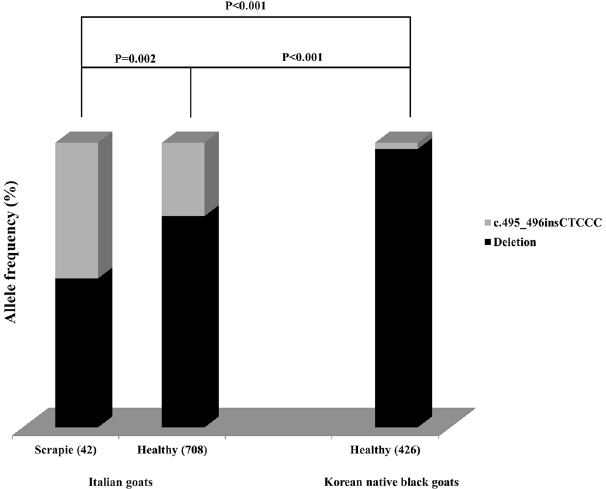
Figure 2. Comparison of the allele distribution of the SPRN c.495_496insCTCCC indel polymorphism between scrapie-affected Italian goats and Korean native black goats. The information of the Italian goats was taken from a previous study 20 . The Italian goats were Maltese, Red Mediterranean, Capra dei Nebrodi and crossed breeds. Differences in allele distribution were calculated by the Chi-square ( χ 2 ) test using SAS 9.4 software.